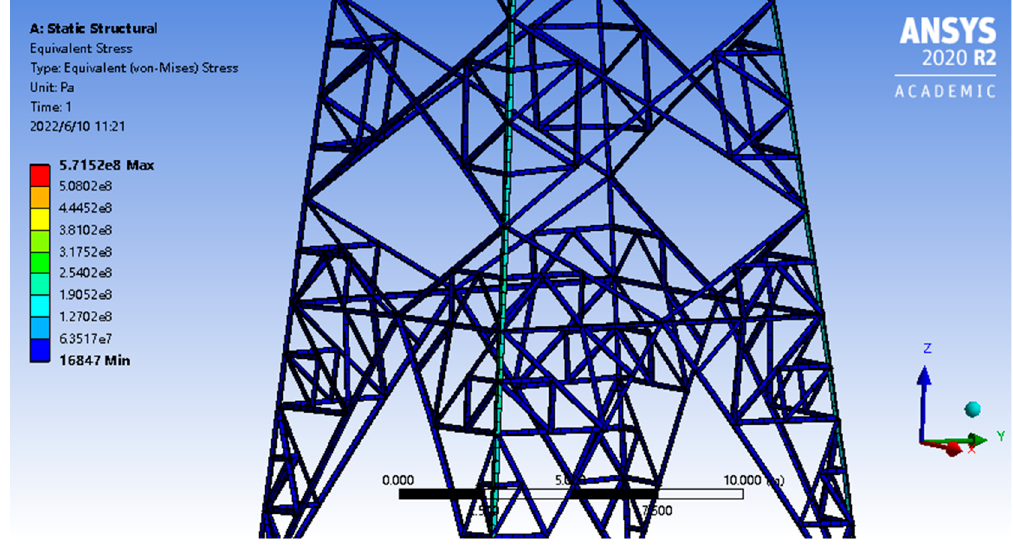
Figure 4. Equivalent force analysis